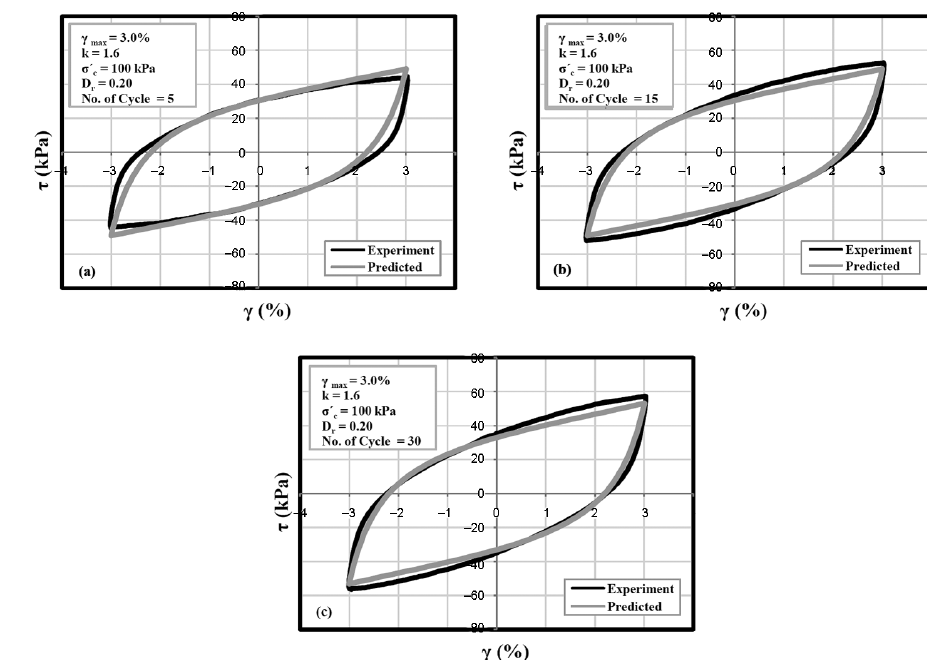
Fig. 10. Experimental hysteresis curves versus predicted curves for the validation data